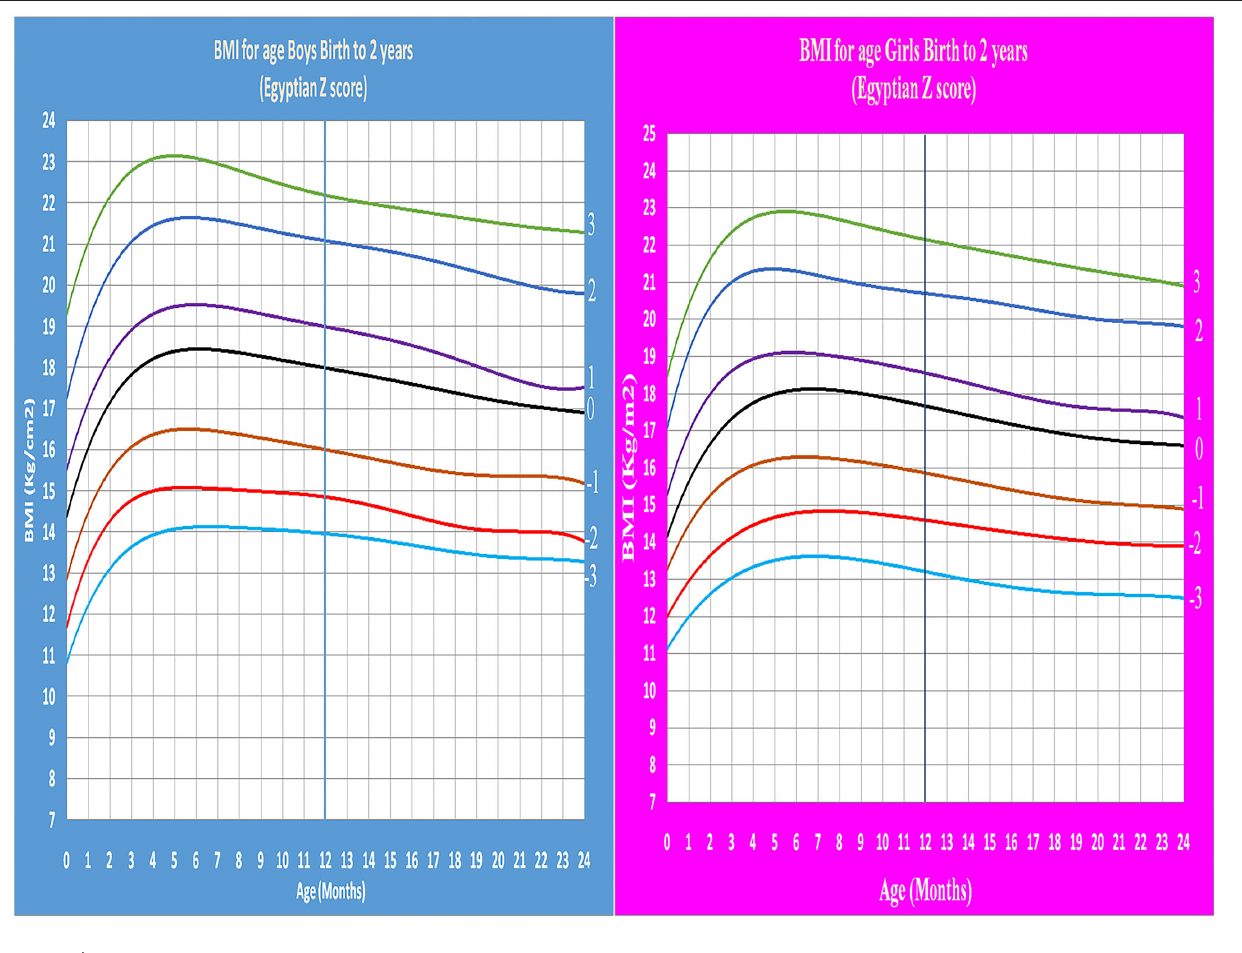
FIGURE 6 | Egyptian Z score BMI for age from birth to 2 years for boys &